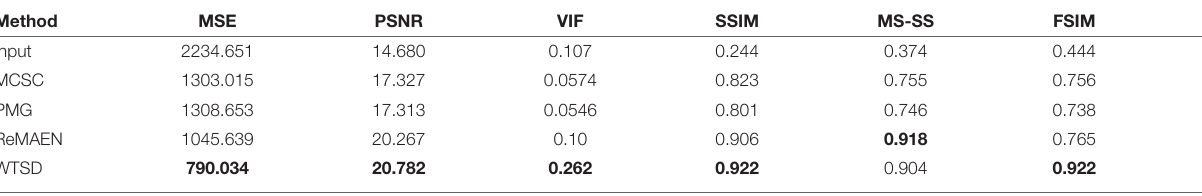
TABLE 1 | Quantitative comparison of different approaches. Method